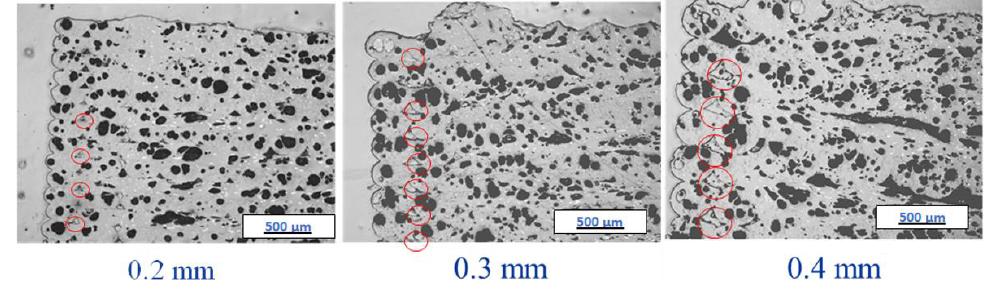
Figure 9. Microstructure and porosity of ABS w/5%CF as a function of layer height. Red circles mark some of the areas where epoxy has filled in a pore. Views at one of the corners for each printed sample are shown.